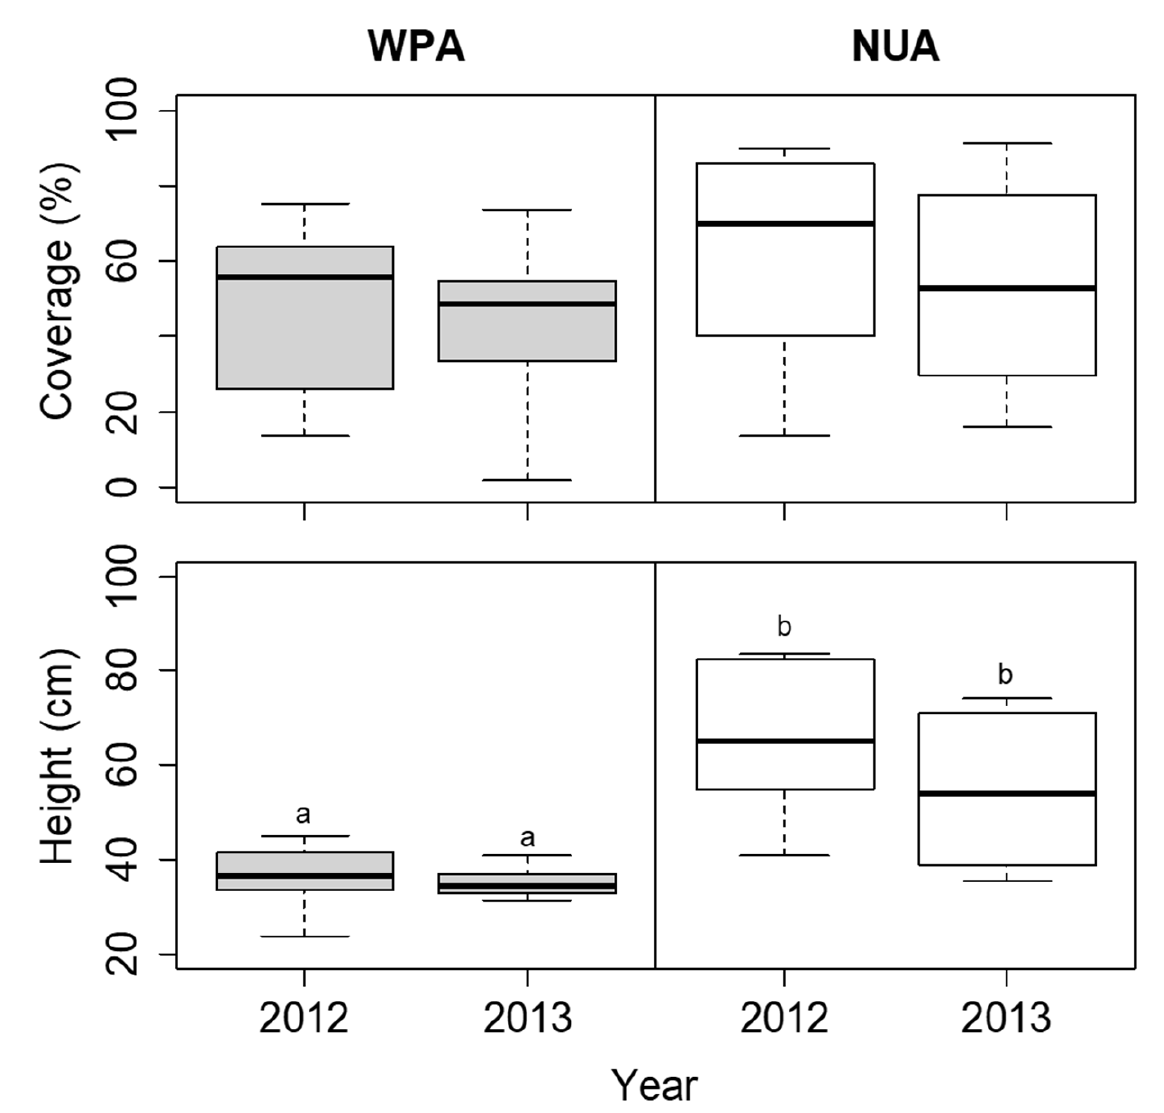
Figure 6. Comparison of coverage and height of Sasa nipponica between the wildlife protected area (WPA) and the neighboring unprotected area (NUA) from 2012 to 2013. Deer hunting was banned at WPA until the 2012 survey, but the ban was lifted before the 2013 survey. The boxplots indicate the first quartile, median, and third quartile. Different letters indicate significant difference between sites in each year ( α = 0.05).